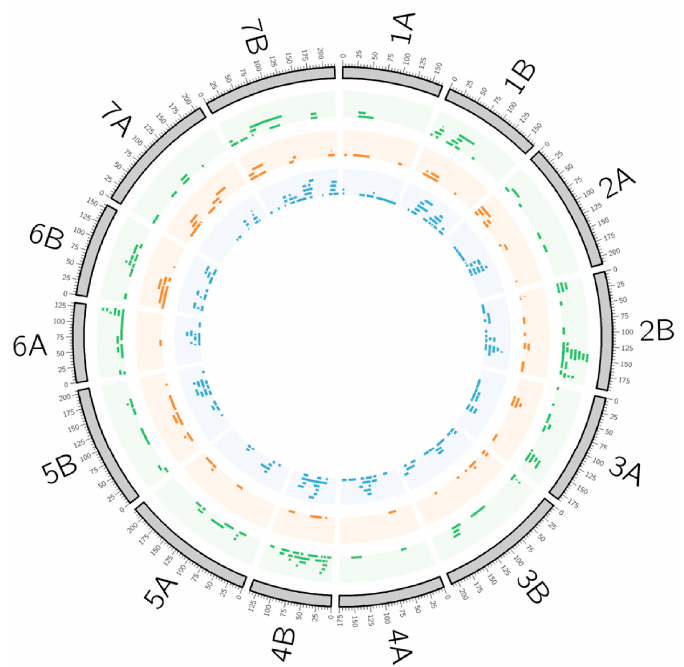
Figure 1. Quantitative trait loci (QTL) projection onto the consensus map developed by Maccaferri et al. [31]. Color code: green, abiotic QTL; orange, biotic QTL; blue, quality QTL.